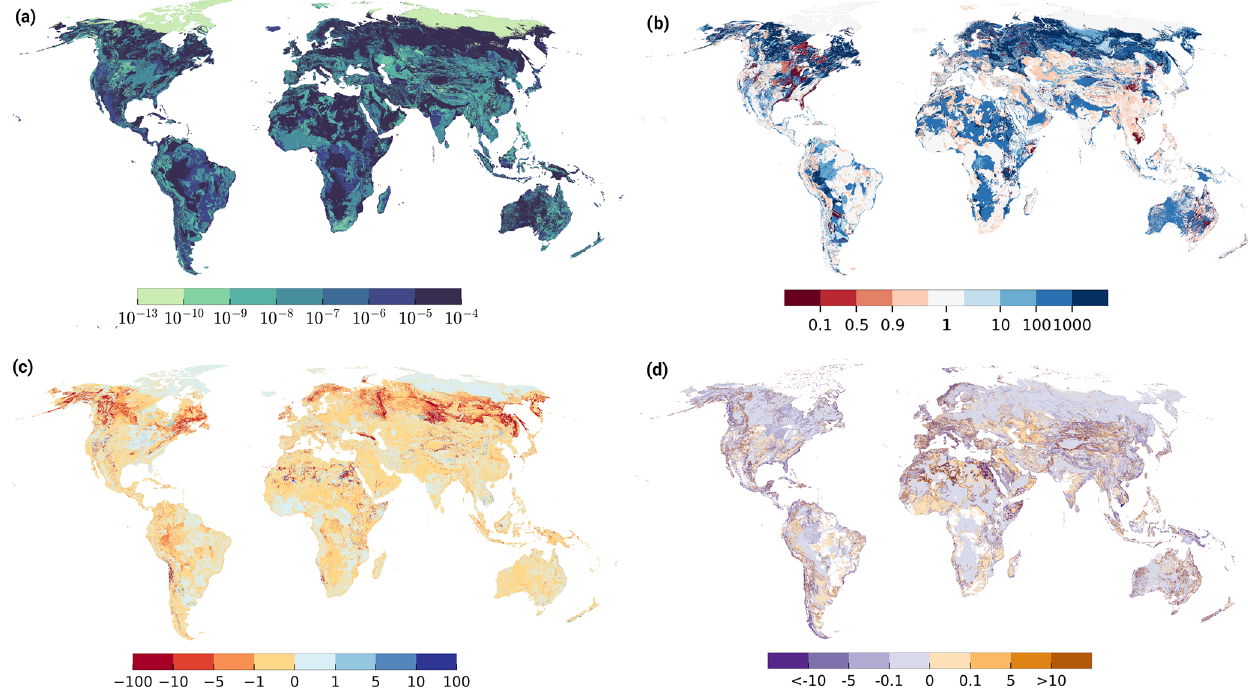
Figure 2. Impact of hydraulic conductivity datasets GLHYMPS 1.0 and GLHYMPS 2.0. (a) GLHYMPS 2.0 (ms − 1 ), (b) K differ- ences, expressed as K (GLHYMPS 2.0) /K (GLHYMPS 1.0). Blue indicates higher values in GLHYMPS 2.0, (c) h (GLHYMPS 2.0) minus h (GLHYMPS 1.0) ( m ), (d) the sensitivity of h to change in the GLHYMPS dataset based on Eq. (6) (white indicates that no index could be